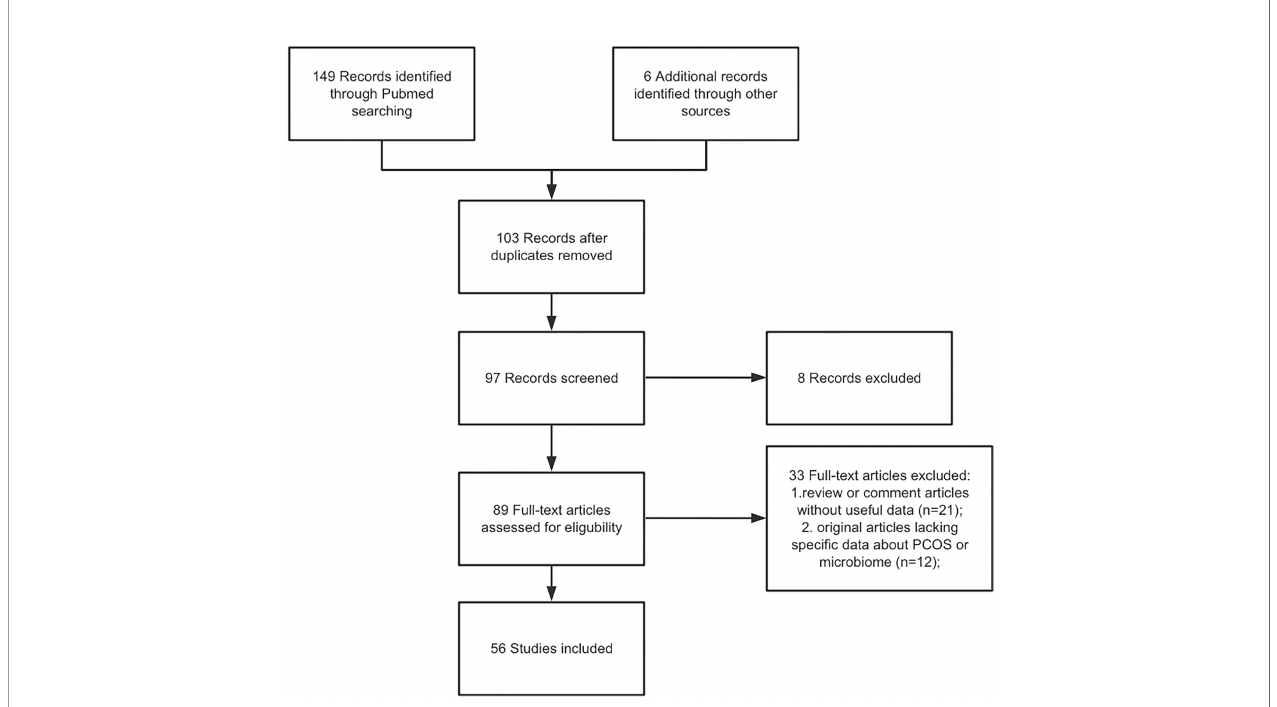
FIGURE 1 | Flow diagram of the searching